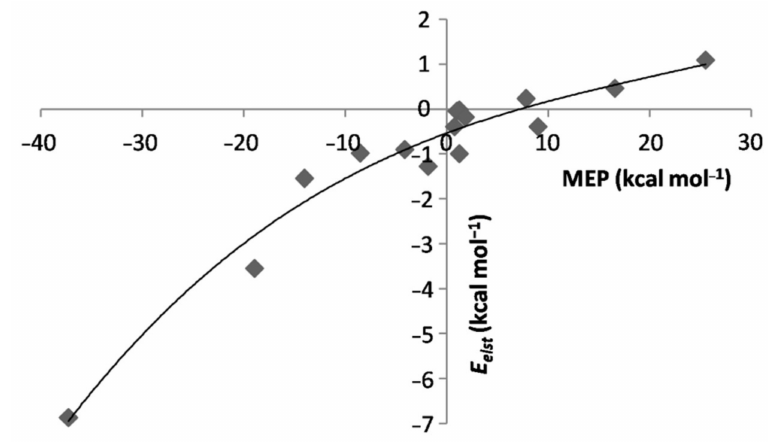
Figure 7. E elst of the L -ArBeO vs. MEP at the V S,max / V S,min of L